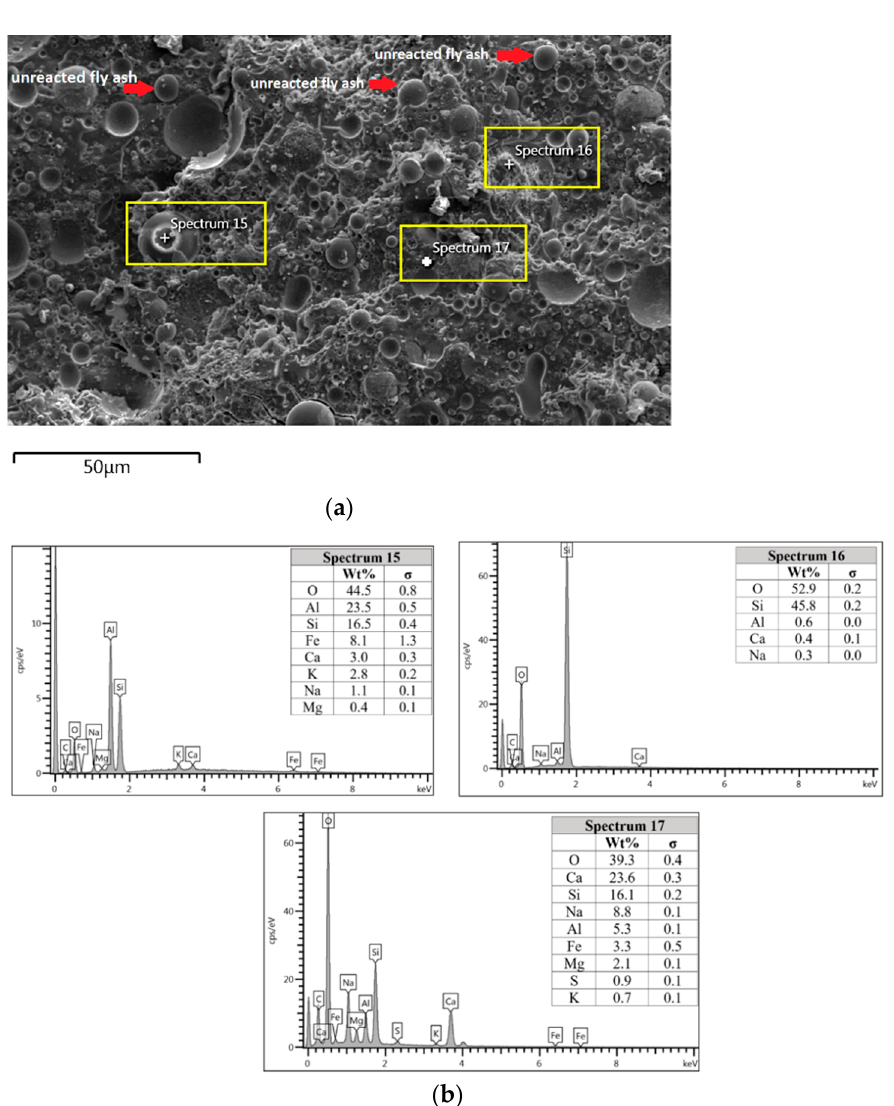
Figure 6. ( a ) Morphology of AAFA specimens cast in dry condition. ( b ) EDS for AAFA specimens cast in dry condition. cast in dry